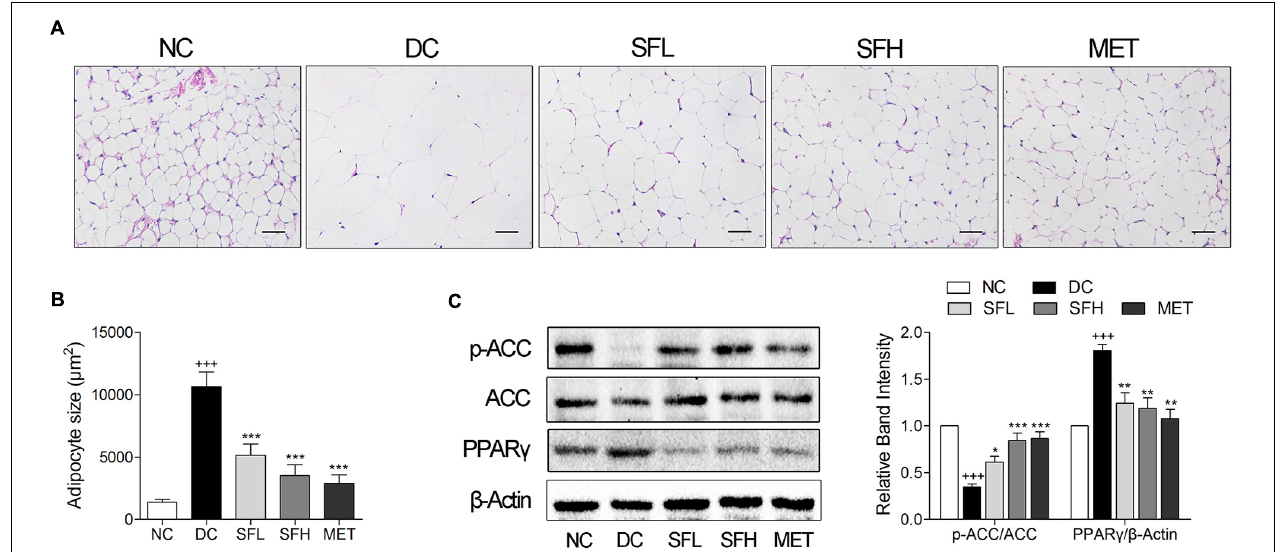
FIGURE 7 | SD-FRE treatment reduced adipocytes size in WAT of KK-Ay mice. (A) HE staining of WAT from KK-Ay mice. Scale bar, 50 µ m. (B) Quantified average adipocyte size in WAT. (C) Western blot analysis of ACC phosphorylation and PPAR γ expression in WAT. Data are mean ± SEM, shown as relative band intensity compared with NC group ( n = 3). +++ P < 0.001 vs. NC group, ∗ P < 0.05, ∗∗ P < 0.01, ∗∗∗ P < 0.001 vs. DC group.